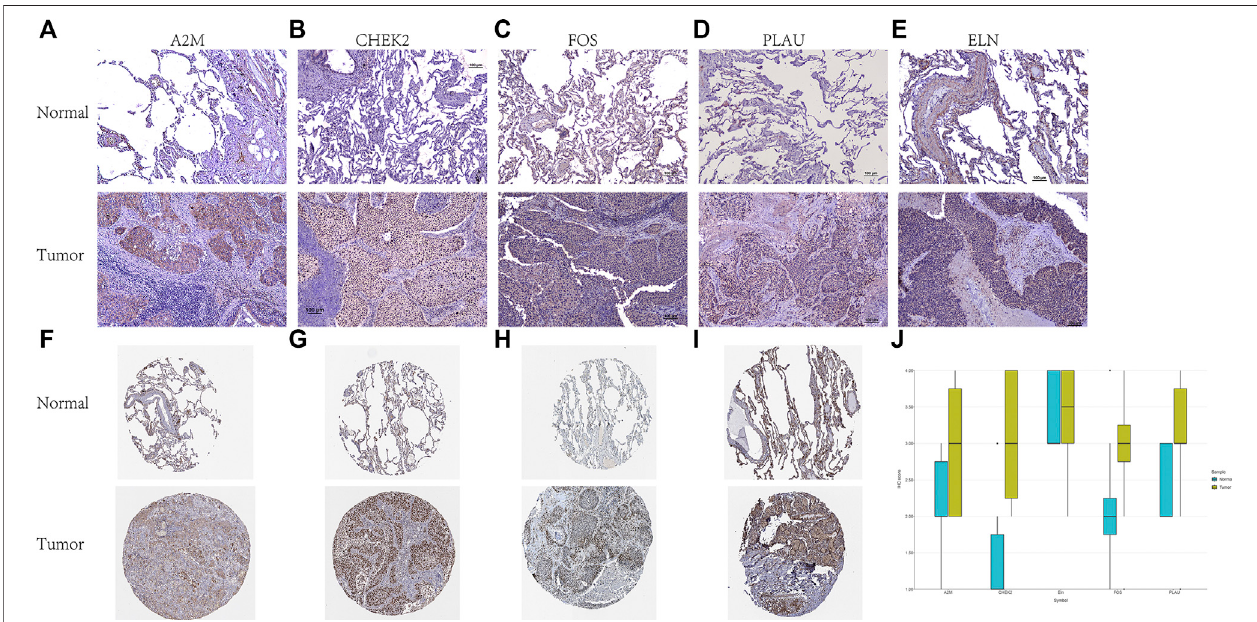
FIGURE 9 | The representative images of IHC staining of fi ve ARGs from SYSUCC. (A) A2M; (B) CHEK2; (C) FOS; (D) PLAU; and (E) ELN. The representative images of IHC staining of four ARGs from Human Protein Atlas. (F) A2M; (G) CHEK2; (H) FOS; and (I) PLAU. (J) The IHC score of 5 ARGs.